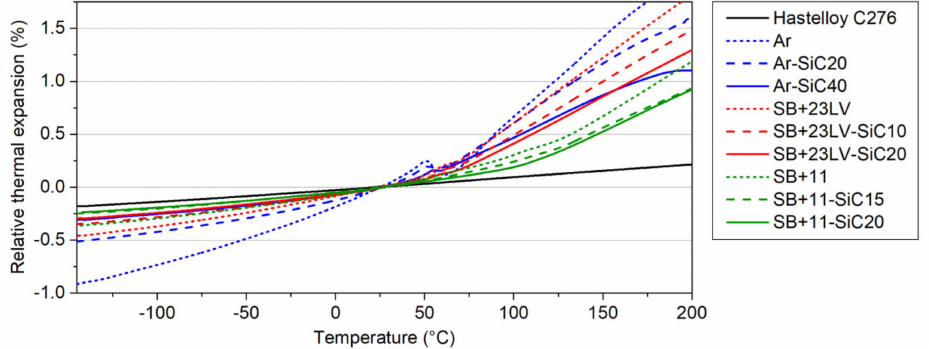
Figure 4. Temperature dependences of relative thermal expansion measured in the resins as received from producer and resin–SiC composites compared with a Hastelloy C276 ® .